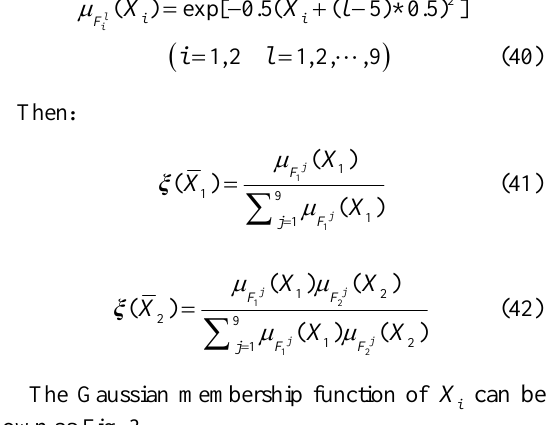
Fig. 3 The Gaussian membership function of